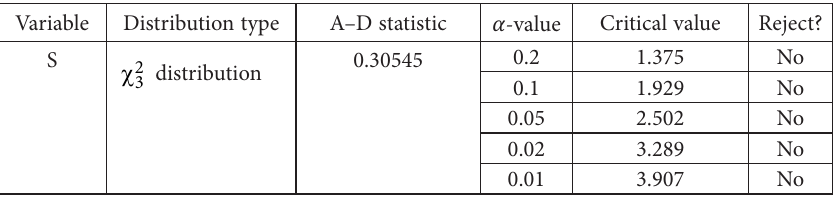
Table 5. A–D test